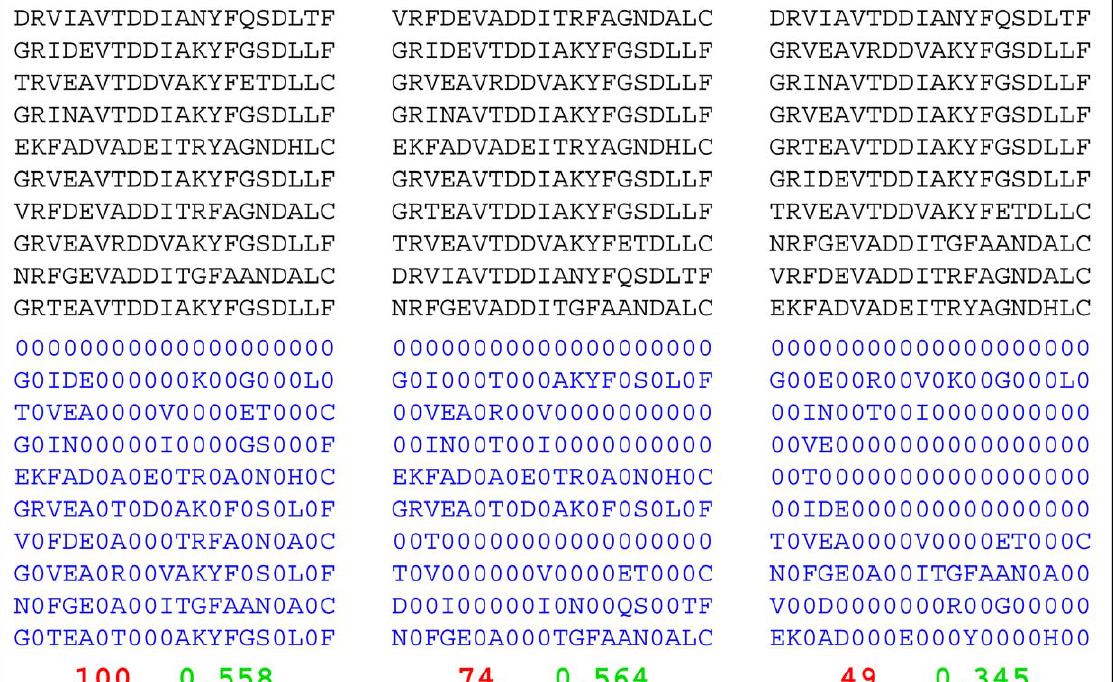
Figure 2. The normal/binary (nb) method. The upper half of the panel shows the same 10 sequences in three different orders. The lower half of the panel shows the corresponding normal/binary translations. The number of non-zero elements and the mean MI of the normal/binary alignments are highlighted in red and green, respectively. The , MI . reaches its lowest values only when the number of non-zero elements is fully minimized.